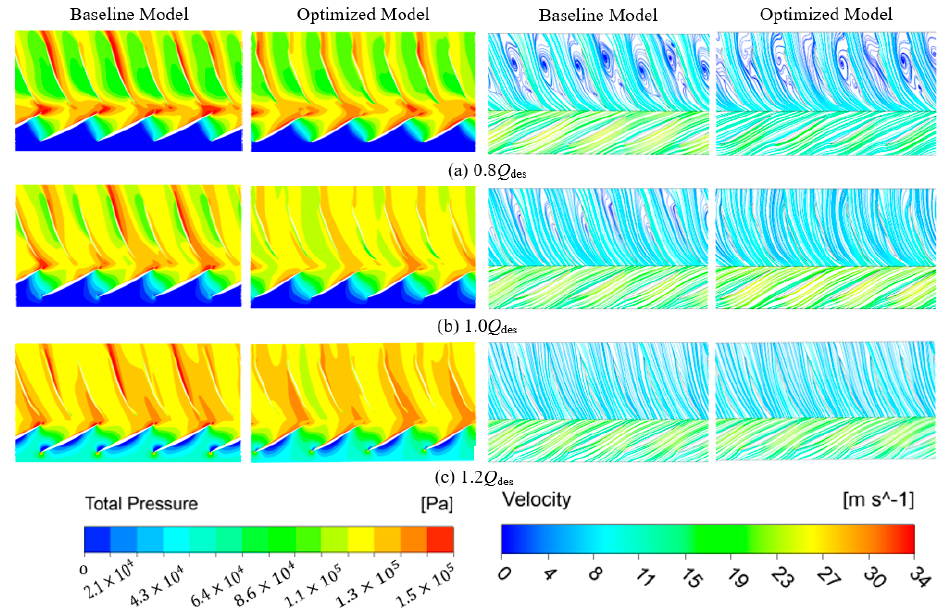
Figure 13. Comparison of the internal flow field between the optimized model and baseline model.